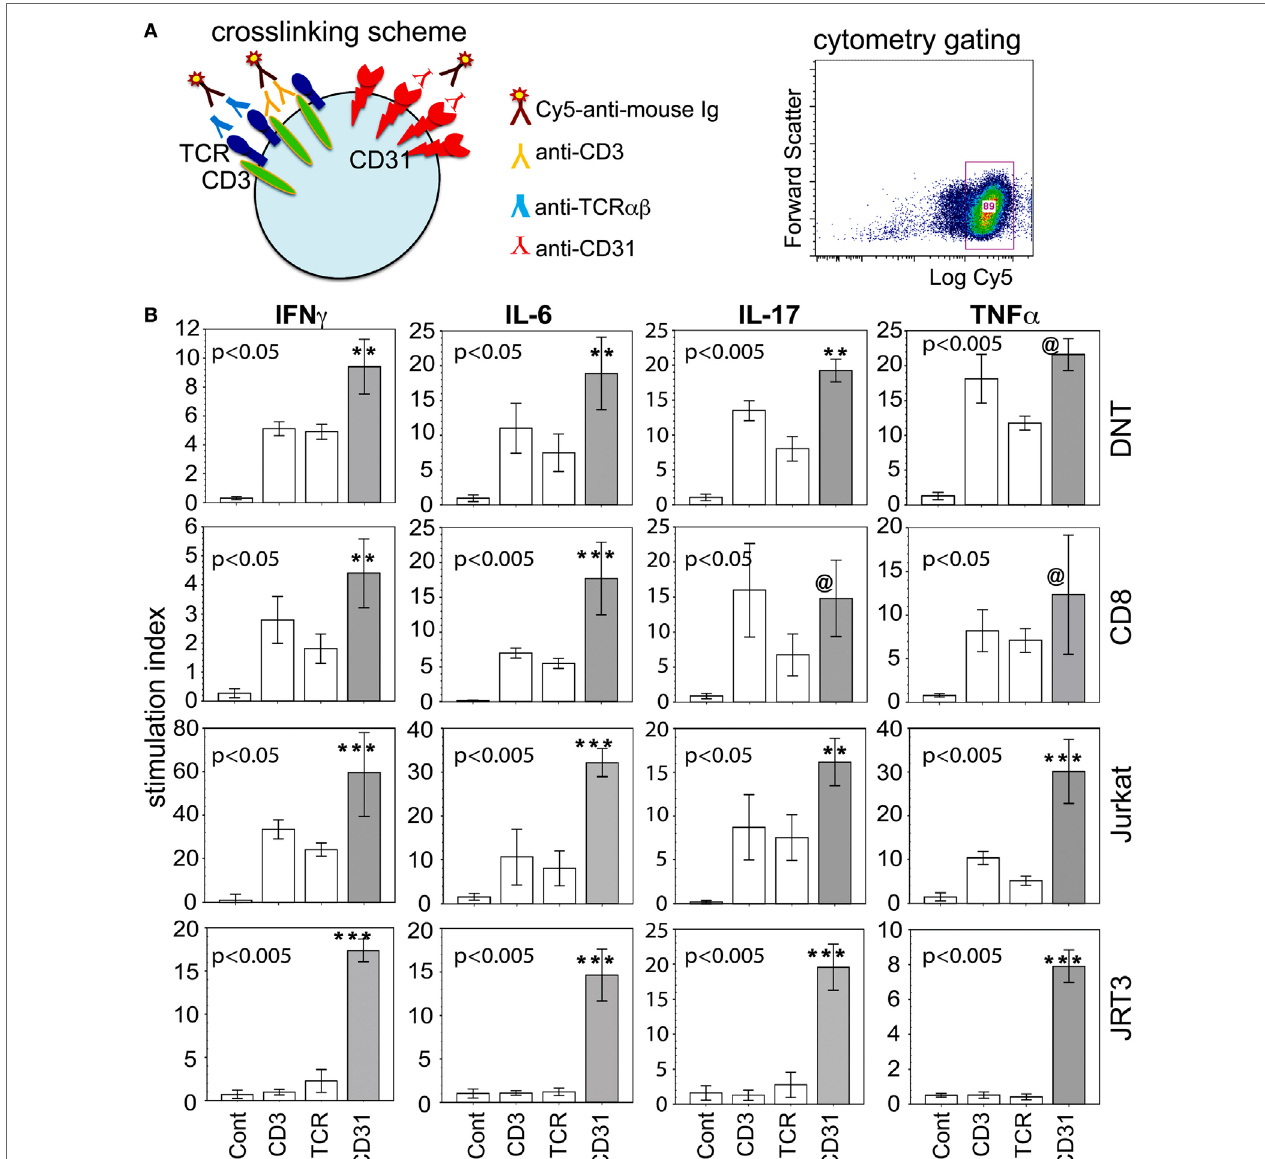
FigUre 3 | CD31 ligation alone is sufficient to induce intracellular expression of cytokines. (a) Diagram of receptor crosslinking with specific antibody, and the relevant gate of crosslinked (Cy5 + ) cells for subsequent cytometric analyses. (B) The data shown (bar means, SD whiskers; n = 5–11 per group) are intracellular levels of IFN γ , IL-6, IL-17, and TNF α in synovial CD31 + CD28 null double negative (DN) and CD8 + αβ T cells within 6 h of stimulation via CD3, TCR αβ , CD31, or IgG control. The data were expressed as stimulation index to normalize intrinsic variability between individual donors and culture batch differences of Jurkat or JRT3 cells. The plots were constructed as in Figure 1 . The indicated P -values were determined by Kruskal–Wallis ANOVA. Post hoc group comparisons by Tukey: [***] and [**] P < 0.005 and P < 0.05, respectively, indicate CD31 crosslinking was significantly different from TCR or CD3 crosslinking and the IgG control [Cont] for synovial DN and CD8 + T cells, Jurkat, and JRT3; [@] indicates CD31 crosslinking was not significantly different from TCR and CD3 crosslinking, but was significantly different ( P = 0.001) from the IgG